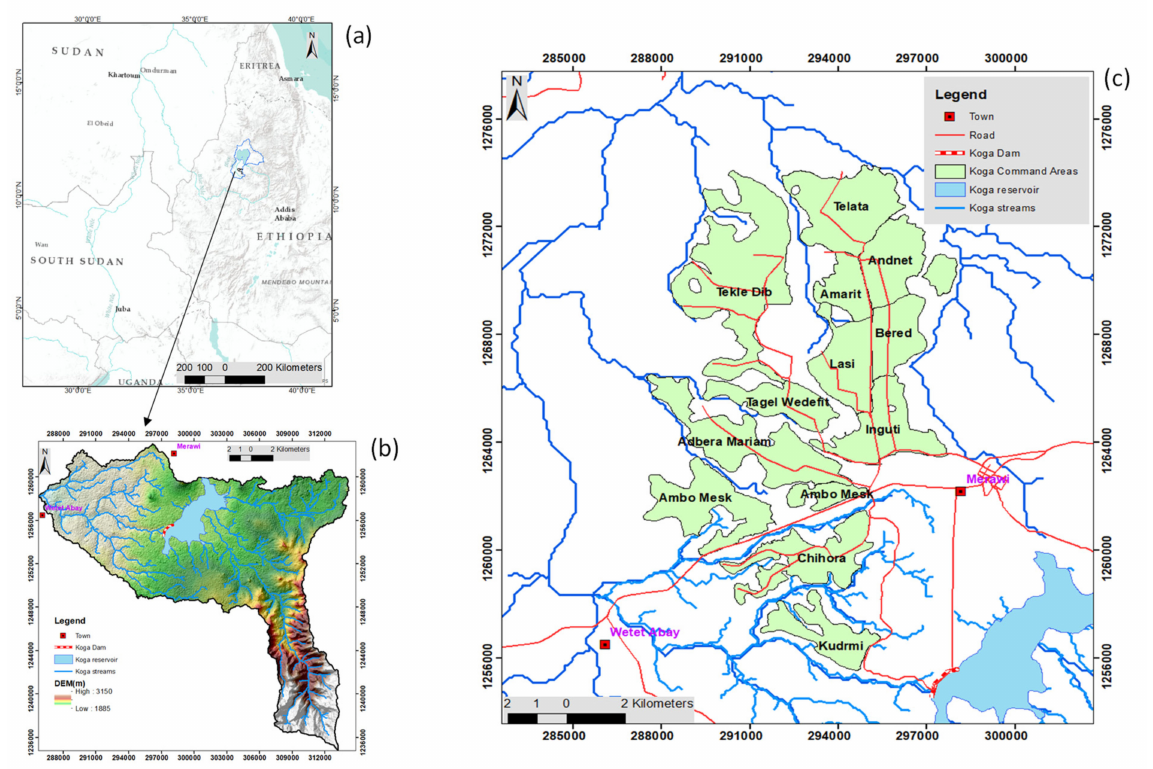
Figure 1. Location of Lake Tana in Ethiopia ( a ), Map of Koga watershed ( b ), and Map of Koga irrigation scheme ( c ).